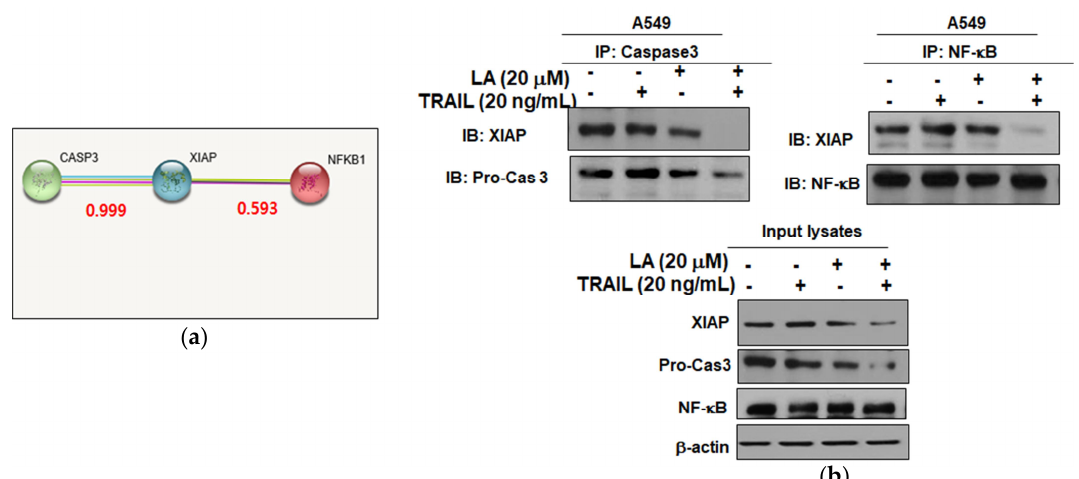
Figure 5. Combined effect of LA and TRAIL on XIAP interaction with caspase3 and NF-κB in A549 non-small cell lung cancer cells. ( a ) XIAP interacts with caspase3 and NF-κB in the STRING database. Red text (interaction score). ( b ) A549 cells were treated with LA (20 μM) and/or TRAIL (20 ng/mL) for 24 h. Immunoprecipitation (IP) was performed with lysates from A549 cells using anti-caspase3 and anti-NF-κB antibodies. Western blot analysis was performed to detect XIAP in whole cell lysates. Western blot analysis was performed to detect XIAP, Pro-cas3, and NF-κB in input lysates. Input lysates indicated that the 5% pre-immunoprecipitated samples and β -actin levels were confirmed as being equivalent to protein loading.